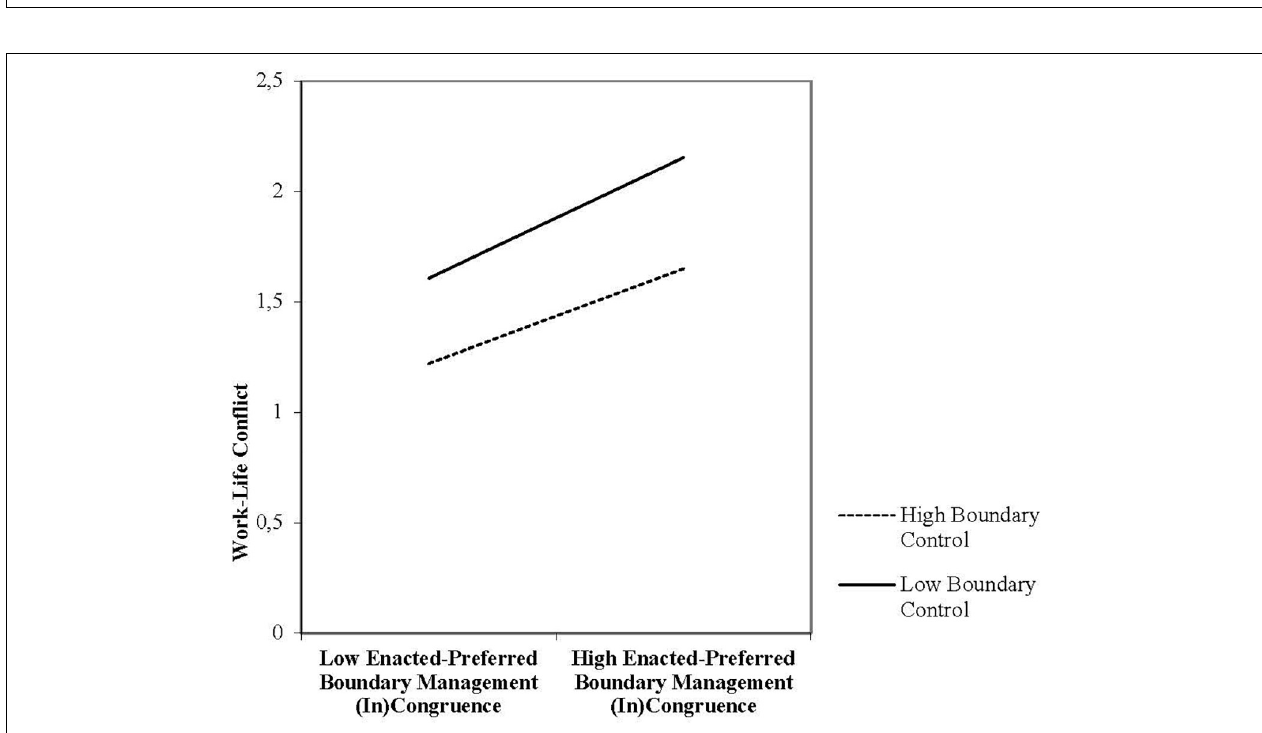
FIGURE 3 | Moderation of the effect of Boundary Management Incongruence (on a continuum from low = “distance” to high = “intrusion”) Work-Life Conflict at values of the moderator Boundary Control.